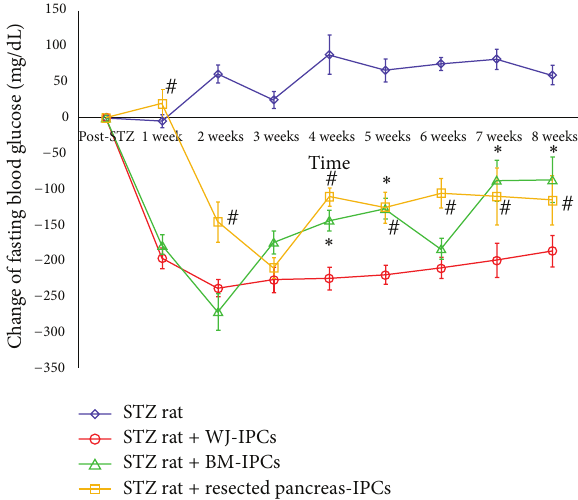
Figure 4: Changes in blood glucose levels in STZ-induced diabetic rats (study group: transplantation of IPCs into the portal vein via the Port-A-Cath with Wharton’s jelly MSCs, BM-MSCs, and resected pancreas; STZ group: STZ-induced diabetic rats without transplantation of insulin-producing cells) Results are presented as the mean ± SD for 6 rats. ∗ : 𝑃 < 0.05 BM-IPCs group compared to WJ-IPCs group; # : 𝑃 < 0.05 resected pancreas-IPCs compared to WJ-IPCs